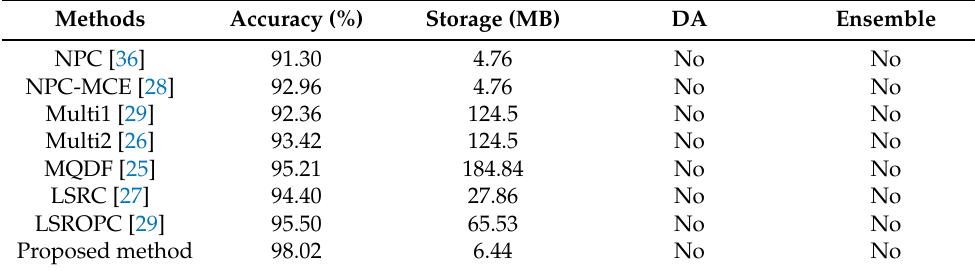
Table 6. Performance comparison of various methods on the GB1